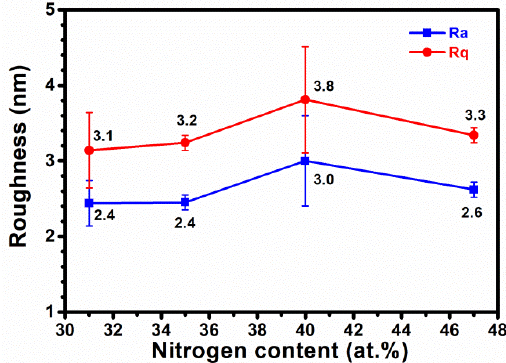
Figure 3. ( a ) XTEM and ( b ) HRTEM images of the Cr 51 W 2 N 47 coatings.